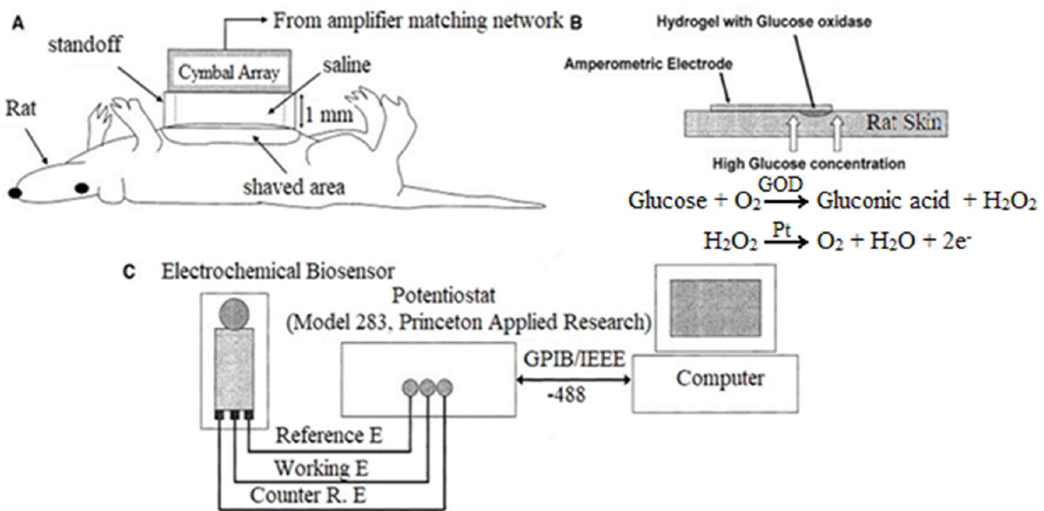
Figure 17. ( a ) Rat on its back; 1-mm thick water-tight stand-off between the shaved abdomen and array. Reservoir inside the stand-off filled with saline. US (ISPTP = 100 mW/cm 2 ) applied to exposed group for 20 min; US not applied to the control. ( b ) In presence of glucose oxidase, glucose becomes gluconic acid via glucono- δ -lactone: hydrogen peroxide is generated as byproduct. Electrochemical biosensor uses the signal caused by oxidation of hydrogen peroxide. One glucose molecule generates an oxygen molecule, a water molecule, and two electrons in the reaction. ( c ) Voltage between working electrode and reference electrode, 0.7 V, applied from potentiostat controlled by computer. At the same time, current between two electrodes is determined by potentiostat and recorded in the computer [50].